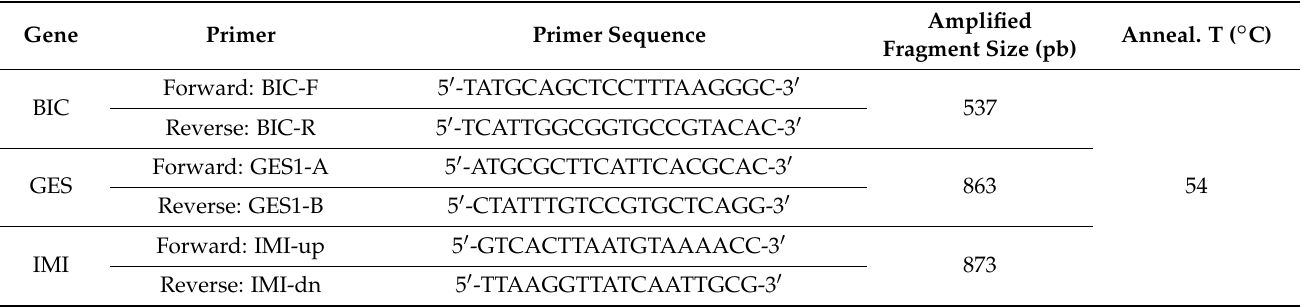
Table 2. The primers used for the amplification of less common class A carbapenemases (BIC, GES, IMI, NMCA,